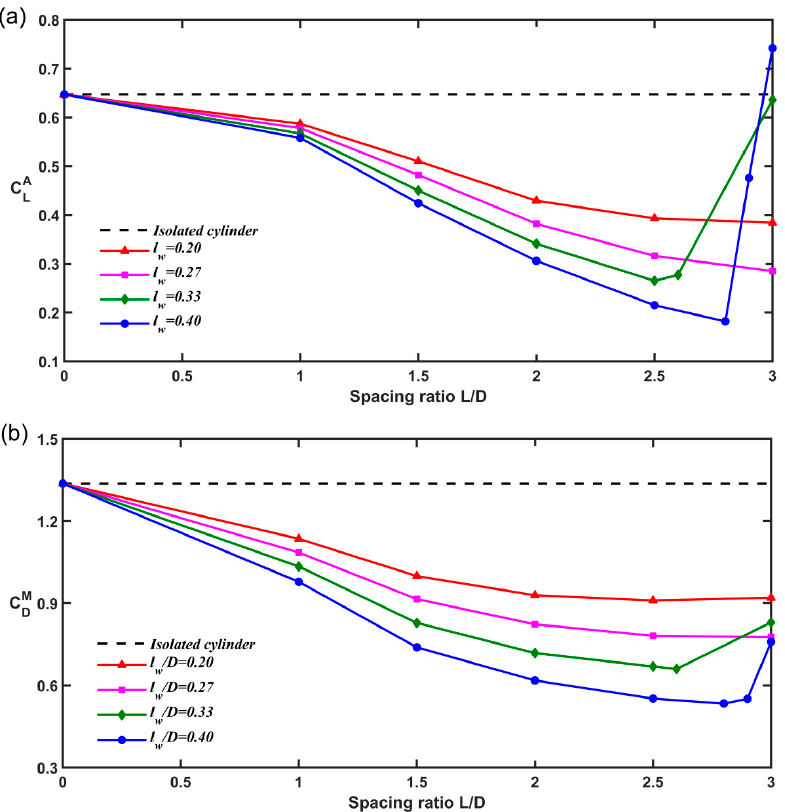
Figure 2. Variation of the force coefficient acting on the main cylinder with spacing ratio at different l w /D, ( a ) amplitude of lift coefficient; ( b ) mean drag coefficient.